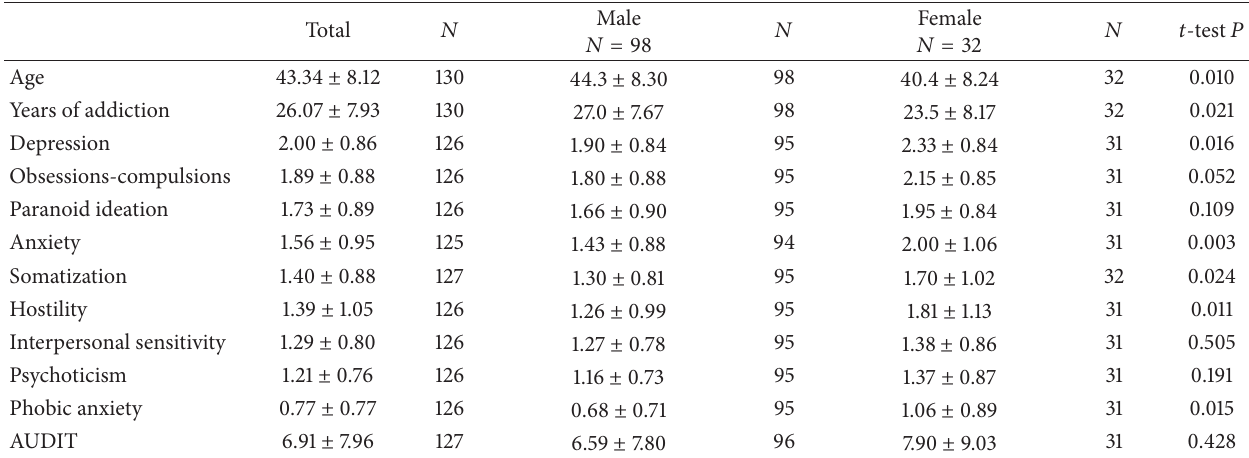
Table 1: Mean scores on SCL-90R subscales and on AUDIT